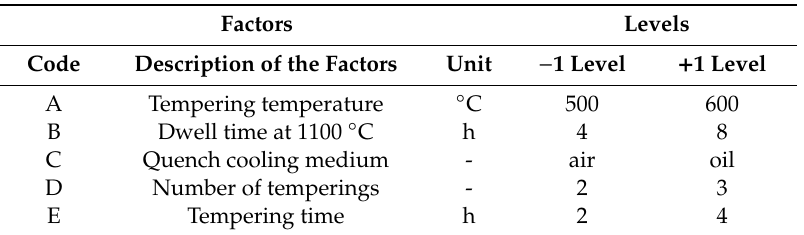
Table 2. Factors and levels.